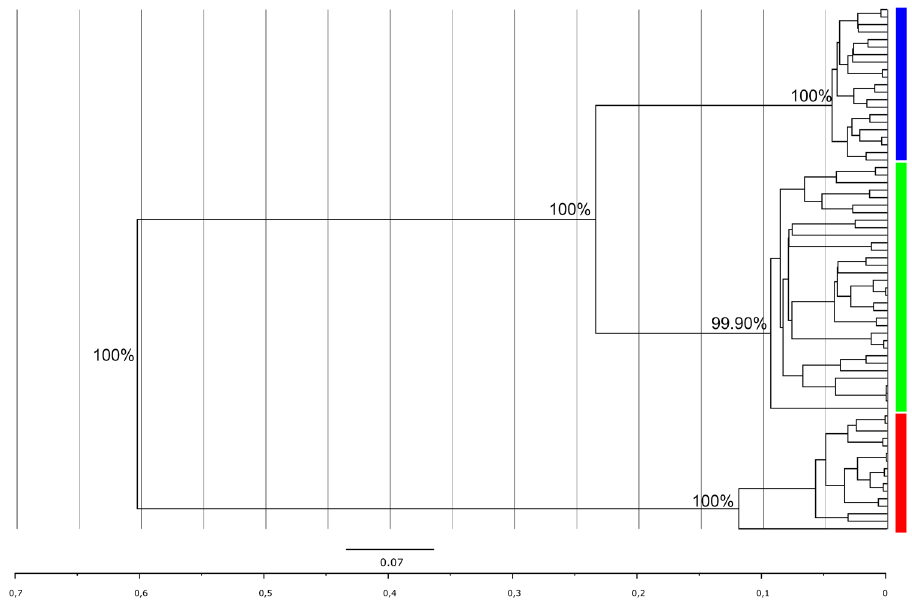
FIGURE 4 | Time-calibrated phylogeny for samples of Schizodon dissimilis from coastal basins of northeastern Brazil. Time is in thousands of years. The color bars in the tree correspond to the populations presented in Fig. 2A.